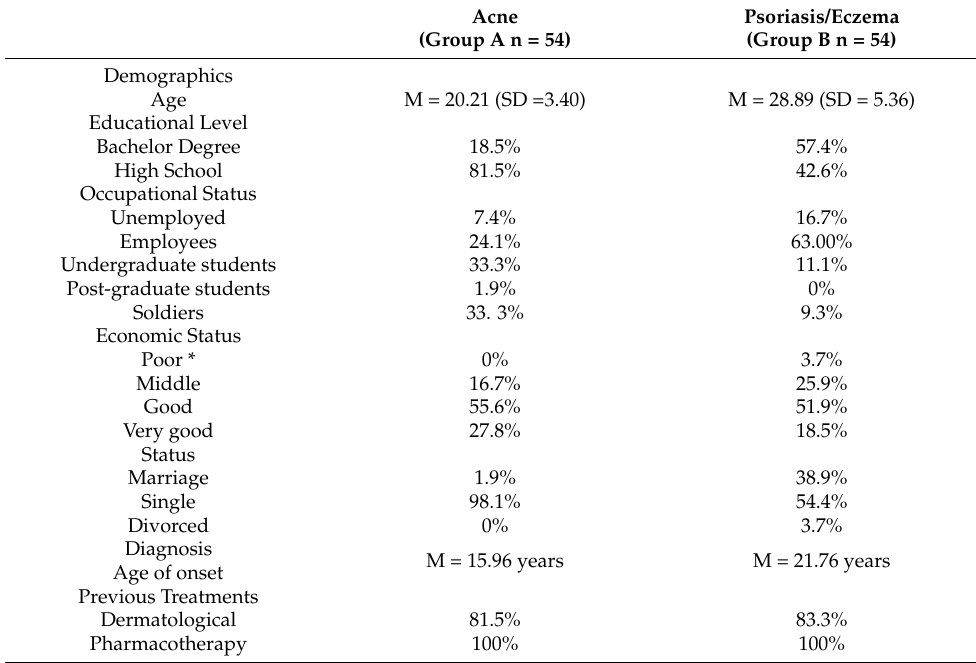
Table 1. Demographics: dermatological diagnosis and pharmacotherapy characteristics of the sample before the beginning of their dermatological treatment (N = 108).